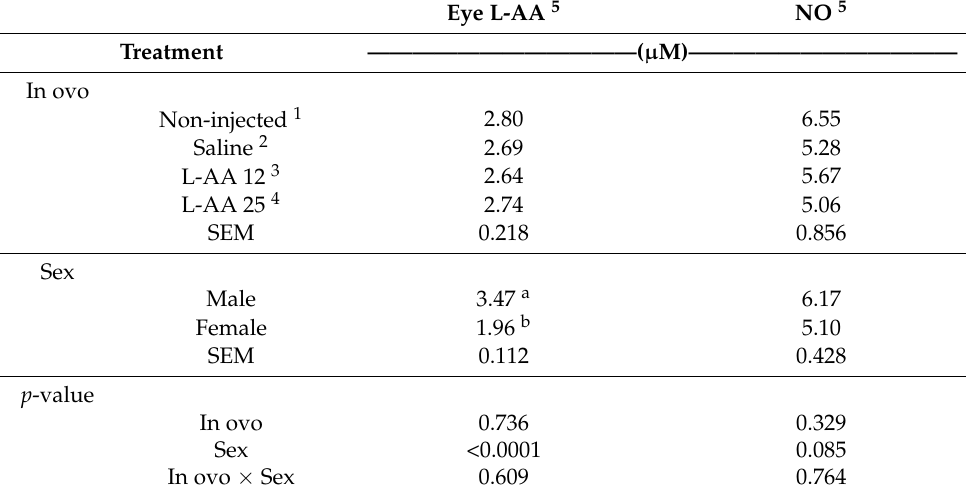
Table 6. Effects of treatment non-injected; saline-injected (saline); saline containing 12 mg of L-ascorbic acid (L-AA 12), or 25 mg of L-ascorbic acid (L-AA 25) at 17 days of incubation (doi) on L-AA concentrations in both eyes (Eye L-AA) and nitric oxide (NO) concentrations in the plasma of male and female broilers at 0 days of post hatch age.